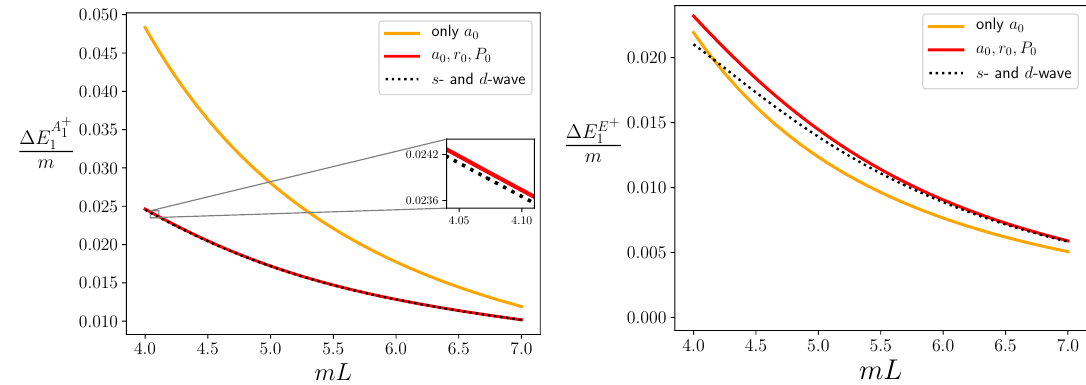
Figure 6. Energy shift of the (cid:12)rst excited state in the A + irrep (left) and E + irrep (right). In the 1 range of mL shown, E free =m = 4 : 7{3 : 9. The quantization condition is solved with only two-particle 1 scattering parameters being nonzero, while = 0. When a parameter is nonzero, its value is K df ; 3 given by eq. (4.7). The solid orange and red curves include only s -wave dimers, the former having only a 0 turned on (\only a 0 "), with the latter having all three s -wave parameters in nonzero K 2 (\ a 0 ; r 0 ; P 0 "). The dotted black line shows the impact of adding d -wave dimers, with a 2 nonzero (\ s - and d -wave").